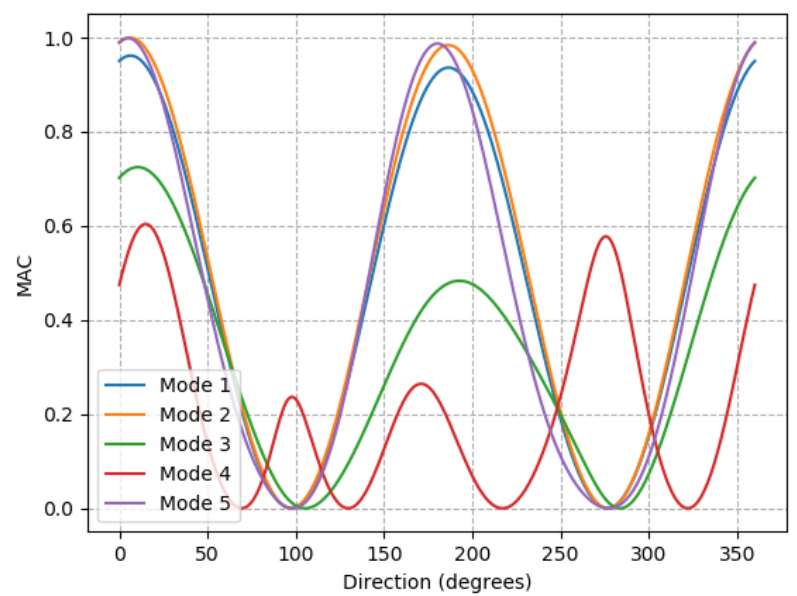
Figure 11. MAC values for the leg damaged case at varying nacelle directions compared to undamaged case at 0 degrees. Mode shapes have been transformed back to original reference.